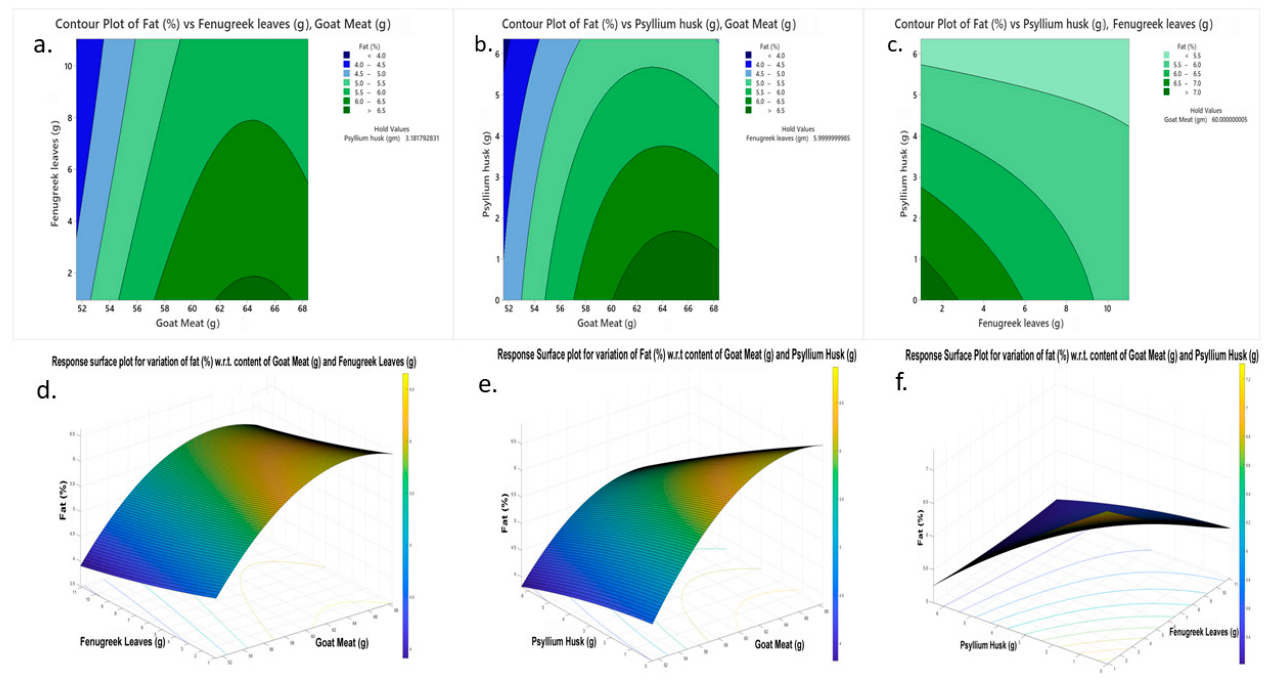
Figure 4. Contour and response surface plots. ( a ): Contour plot of fat (%) vs. FL (g) and GM (g); ( b ): contour plot of fat (%) vs. PH (g) and GM (g); ( c ): contour plot of fat (%) vs. PH (g) and FL (g); ( d ): response surface plot shows the effect of the fat content with FL and GM (g); ( e ): response surface plot shows the effect of the fat content with PH and goat meat (g); ( f ): response surface plot shows the interactive effect of the fat content with FL and PH.